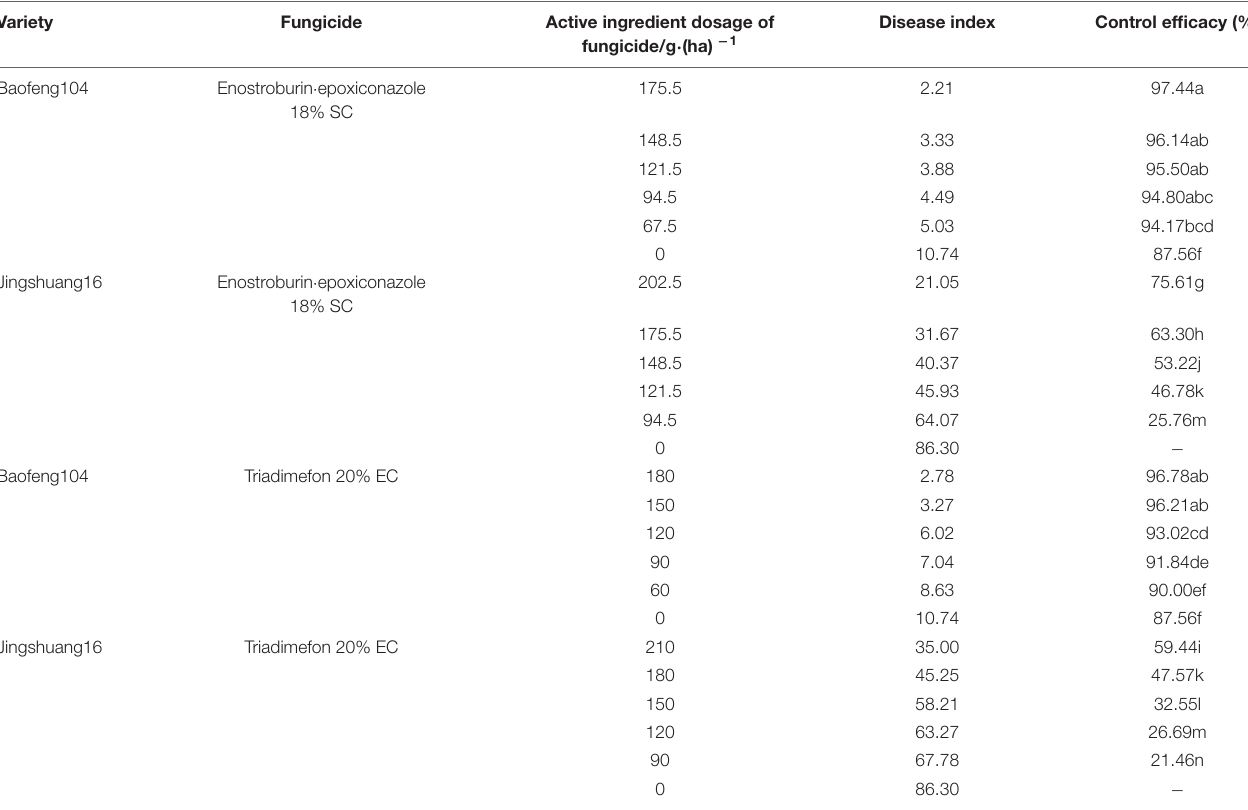
TABLE 4 | Control efficacies of two fungicides to wheat powdery mildew on different wheat resistant varieties in 2019/20 season. Variety Fungicide Active ingredient dosage of fungicide/g · (ha) − 1